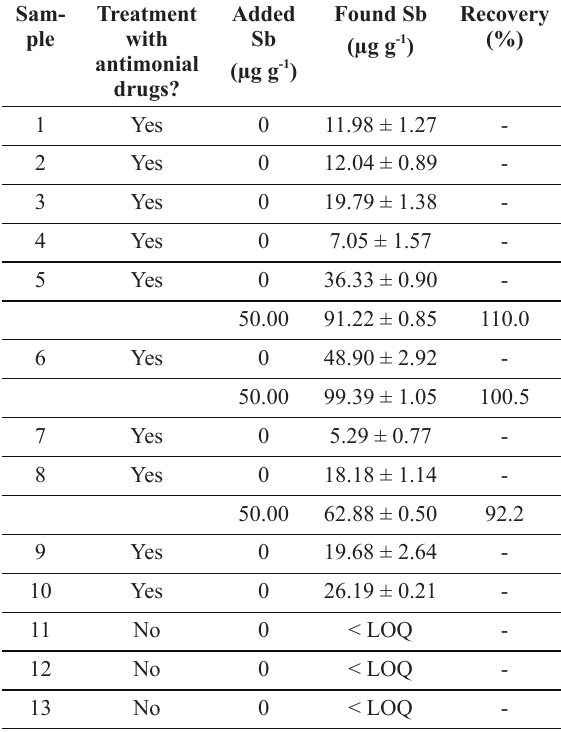
Results of the Sb determination, using the analytical method developed, in hair samples from patients undergoing treatment against Leishmaniasis